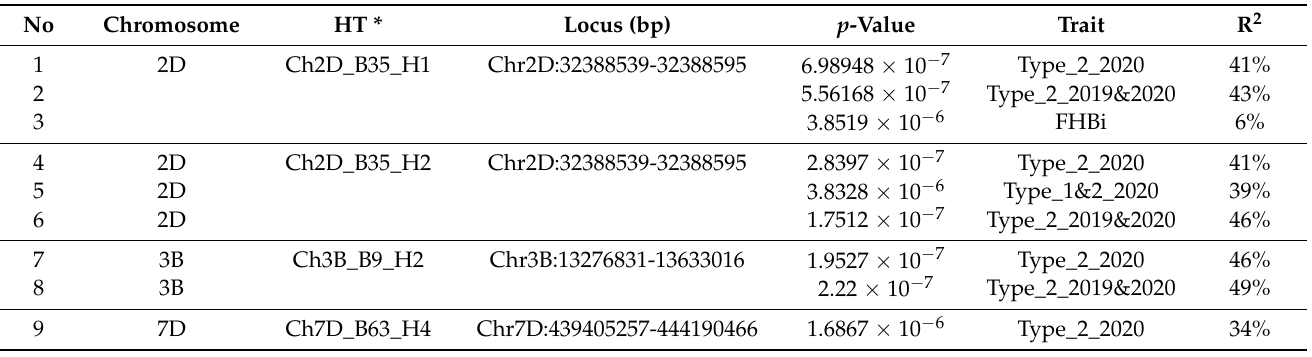
Table 2. GWAS results for 58 wheat lines indicating haplotypes associated with Fusarium head blight resistance parameters.